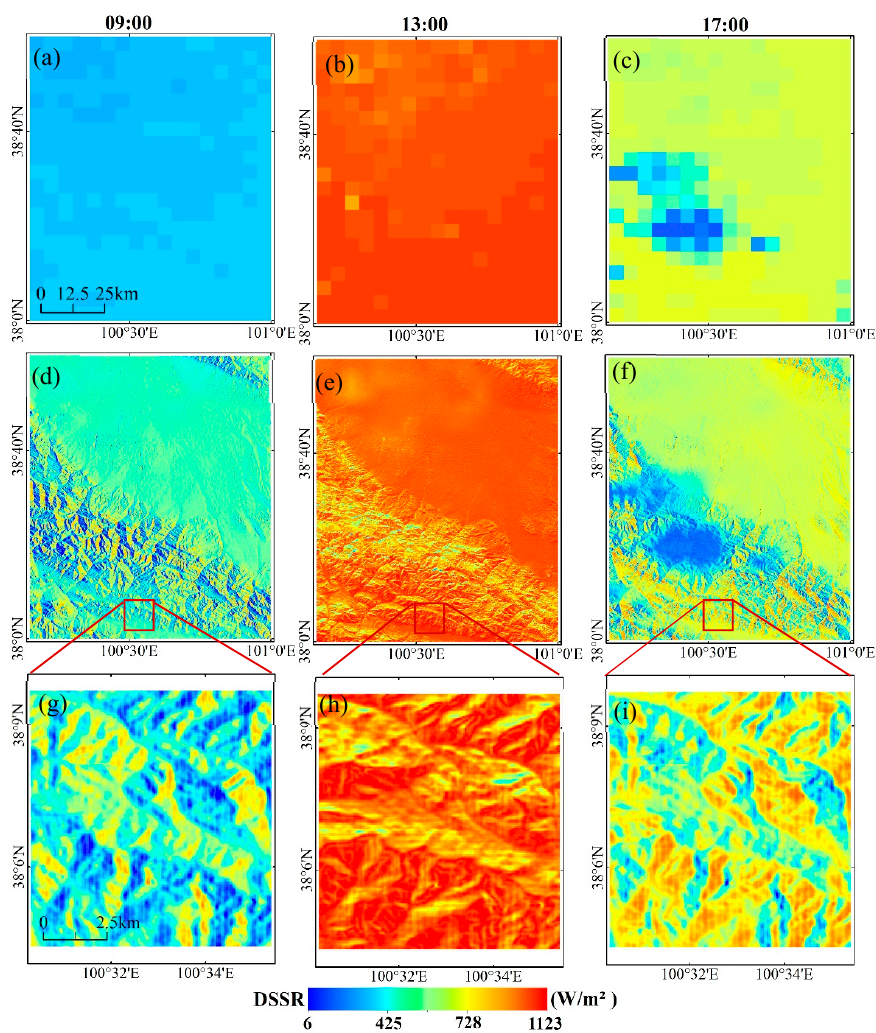
Figure 6. The DSSR spatial distribution at three typical moments (9:00, 13:00, and 17:00 h) on 25 July 2018: ( a – c ) are the original H8 radiation products, ( d – f ) are the downscaled DSSR data, and ( g – i ) show a zoomed-in view of the subregion.